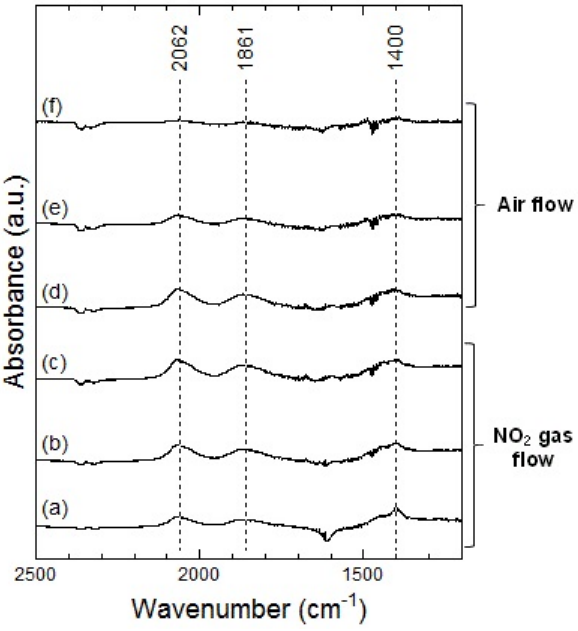
exposure, the powders 2